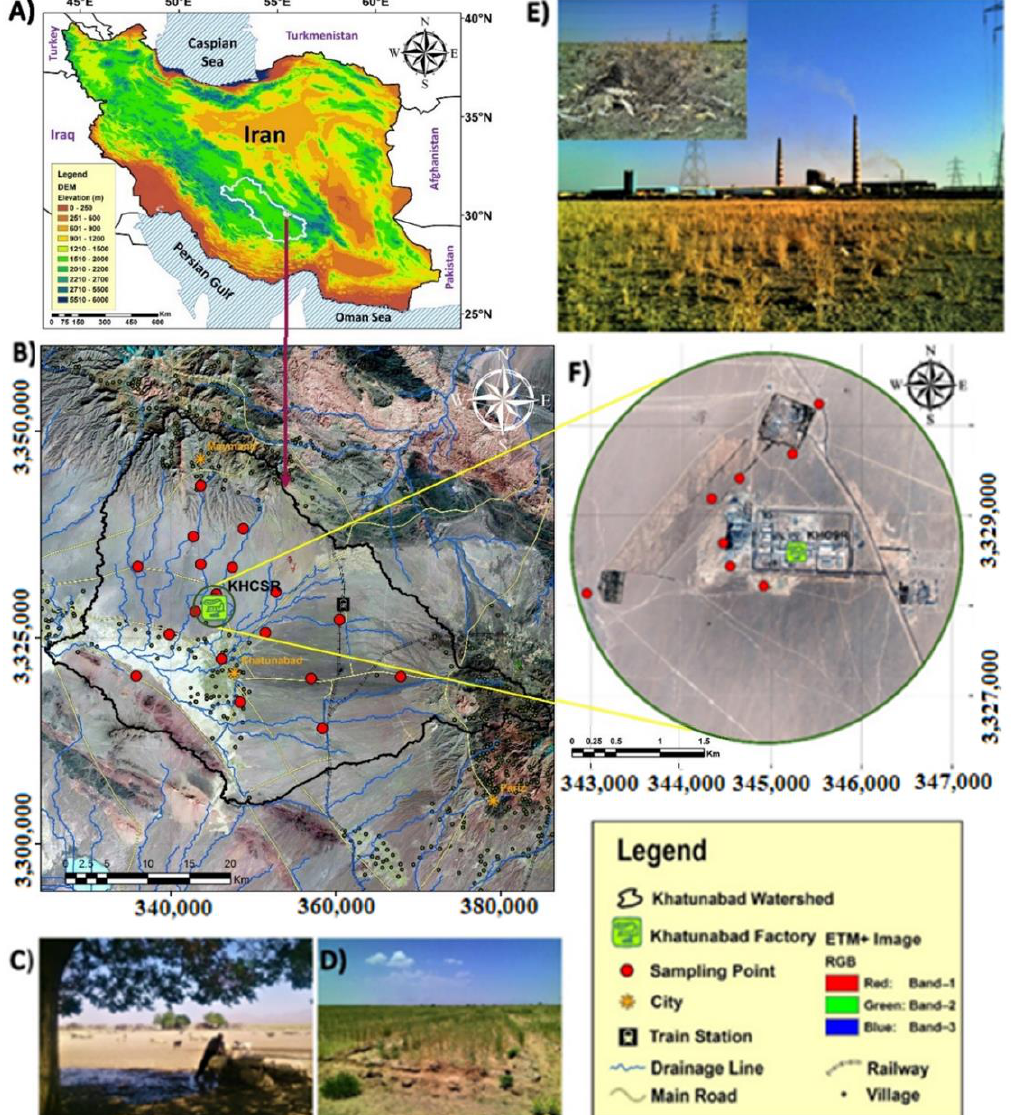
Figure 1. Location of the study area in Iran ( A ), detail map of the Khatunabad area and sampling points (satellite image from Landsat 8) ( B ), livestock around the smelter ( C ), farming around the smelter ( D ), two main towers of the smelter and vegetation destruction through heavy metal contamination ( E ), and zoom view of the copper smelter and refinery ( F ).